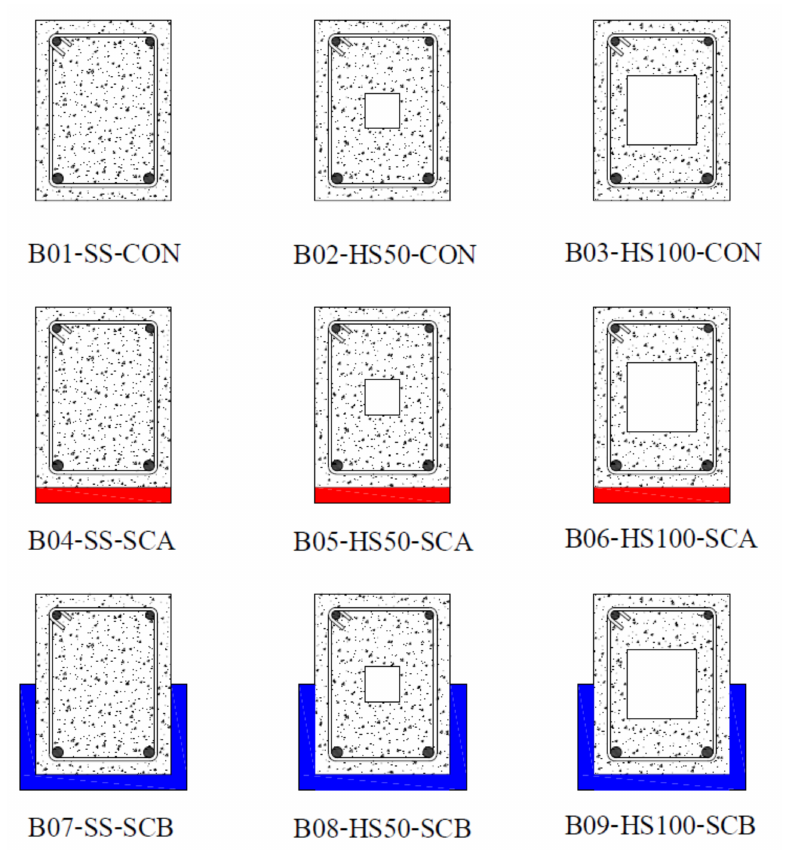
Figure 2. Layout of CFRP sheets.